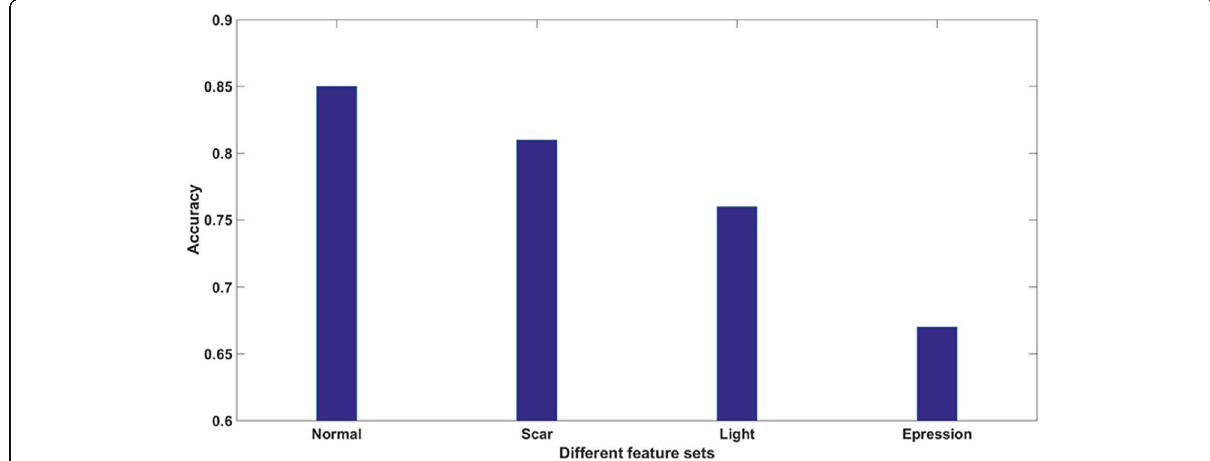
Fig. 7 The recognition rate of different feature sets before